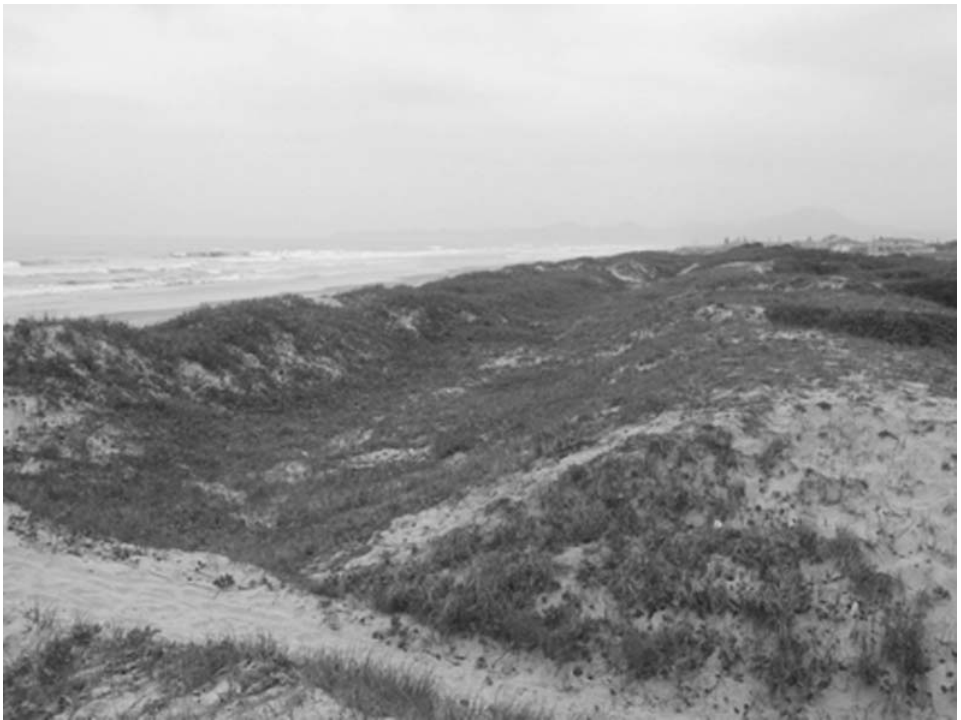
Fig. 3 – Navegantes foredune plain. The active foredune is on the left and separated from the next relict foredune ridge (center of photograph) by a swale. The distance from foredune crest to relict foredune crest varies from approximately 20 to 15 m. Note the parallel lines of foredune ridges separated by swales, and the narrow distance between ridge crests. All ridges and swales have formed by aeolian sand deposition in vegetation on a prograding dissipative